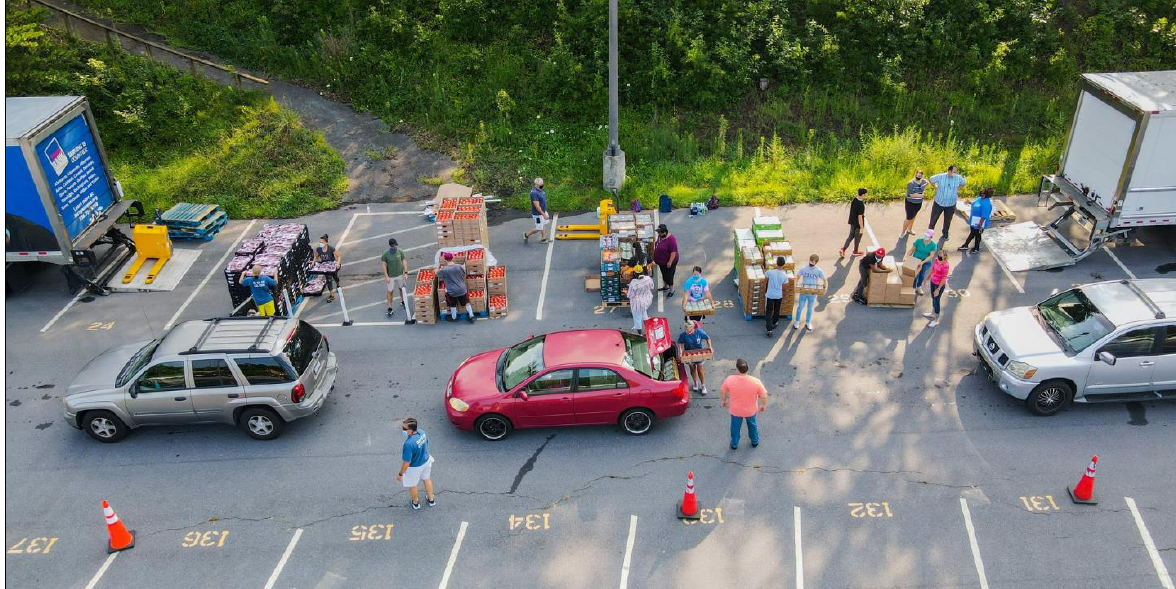
Figure 1. An Example of Emergency Food Box Distribution to Food-Aid